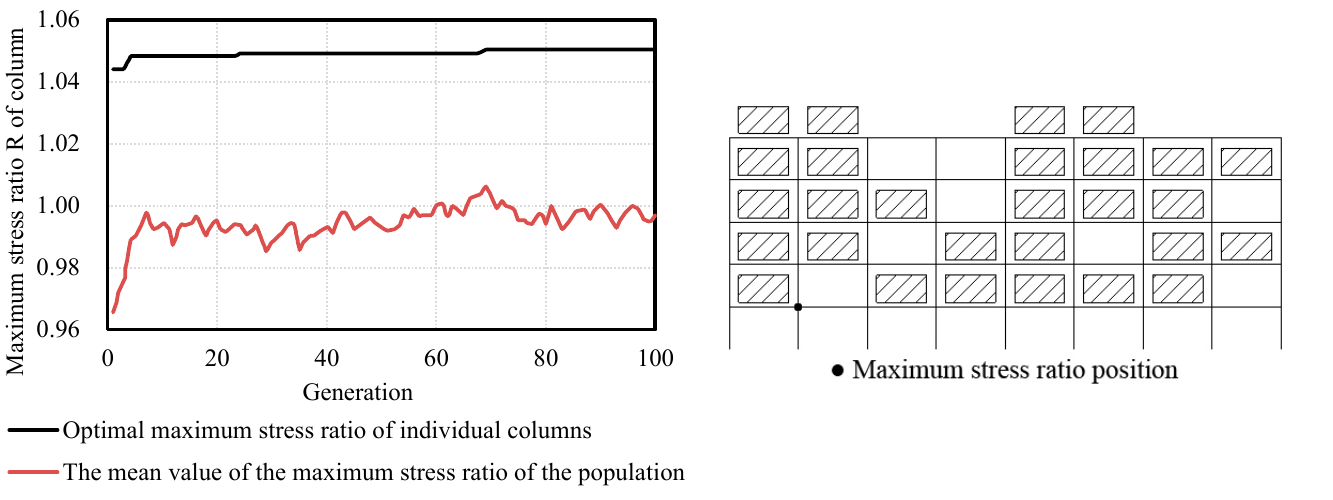
Figure 12. The most unfavorable distribution of load under 80% full load. ( a ) Tracking chart of optimization performance of GA. ( b ) The most unfavorable distribution of load (H = 2.81, P = 0.00).